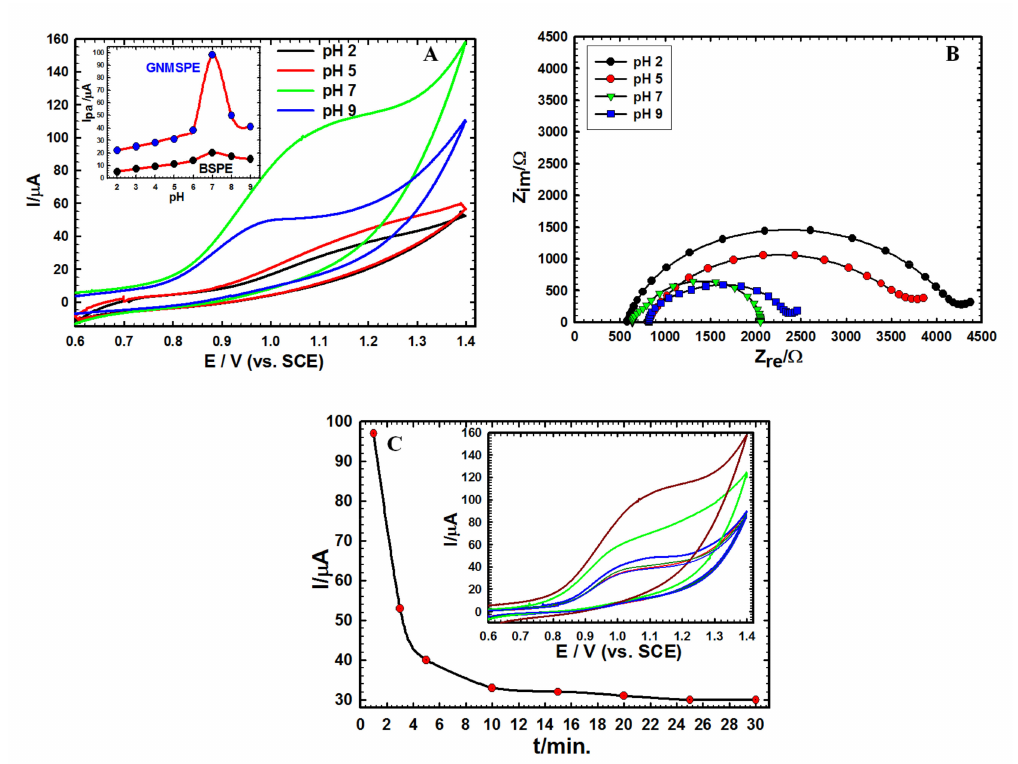
Figure 3. ( A ) CVs of 1.0 mM Moxi on GNMSPE in 0.01 M B-R bu ff er with di ff erent pH values at scan rate 50 mV s − 1 . Inset: variation of anodic peak current (I pa ) for BSPE and GNMSPE as function of pH. ( B ) Nyquist plots of Moxi on GNMSPE at di ff erent pH values. ( C ) Variation of anodic peak current (I pa ) obtained for successive analyses at increasing times (1–30 min.) using the same GNMSPE in B–R bu ff er pH 7.0 containing 1.0 mM Moxi. Inset: the corresponding